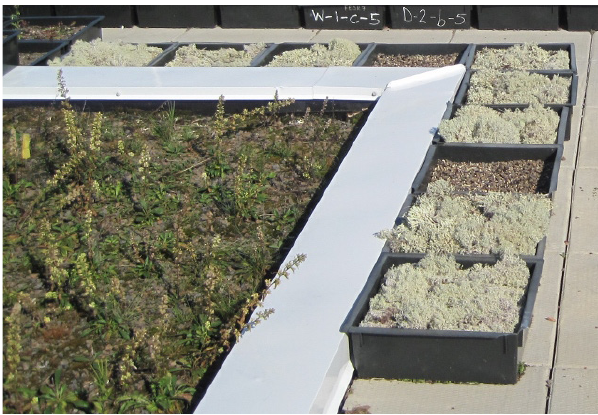
Figure 1. Placement of lichen trial on the east side of the roof of the five-story Atrium building at Saint Mary’s University in Halifax, Nova Scotia, Canada (44 ° 39 ′ N, 63 ° 35 ′